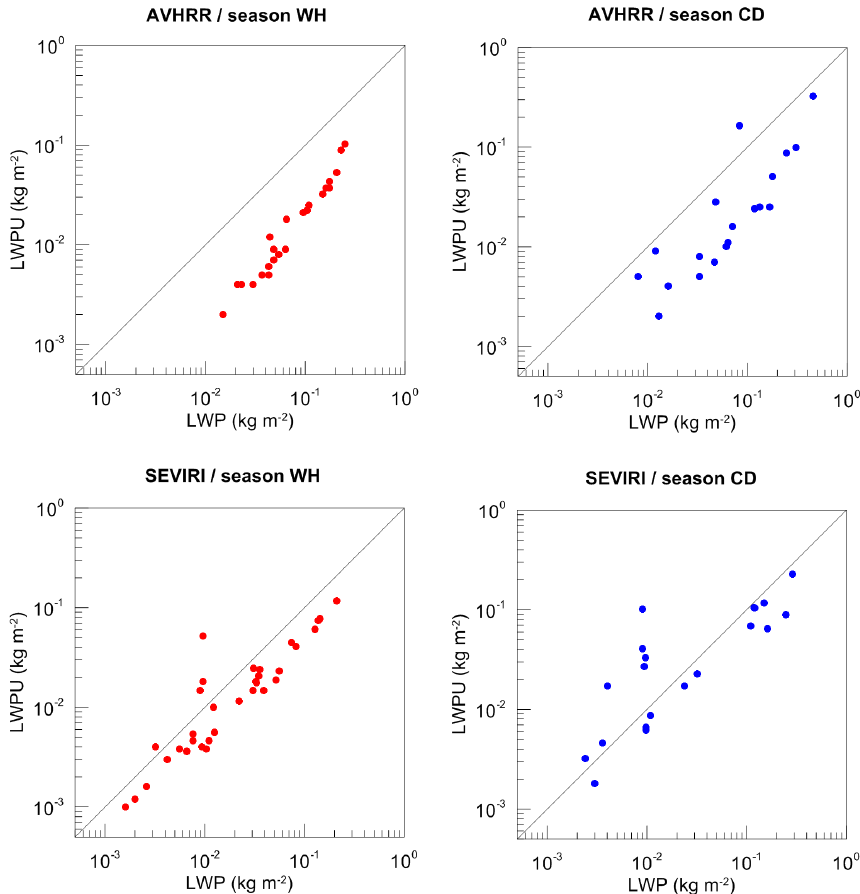
Figure 6. The LWP retrieval uncertainty (LWPU) as a function of LWP value for the AVHRR and SEVIRI instruments and for different seasons (cloudy conditions only).